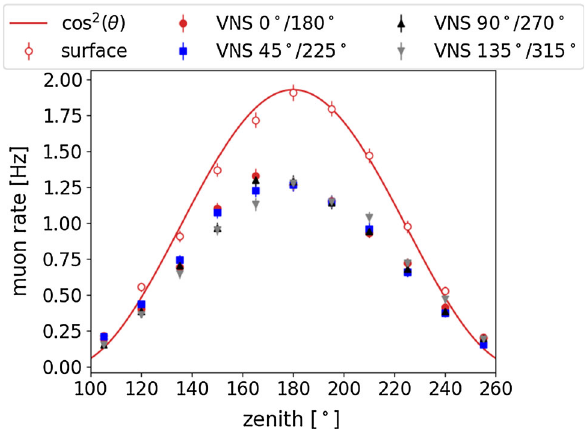
Fig. 3 Measurement of the muon rate at the surface (open data points) and at the VNS (filled data points) as a function of zenith angle for different azimuthal orientations. The muon flux at the surface follows the expected cos 2 θ -law. Uncertainties are statistical only